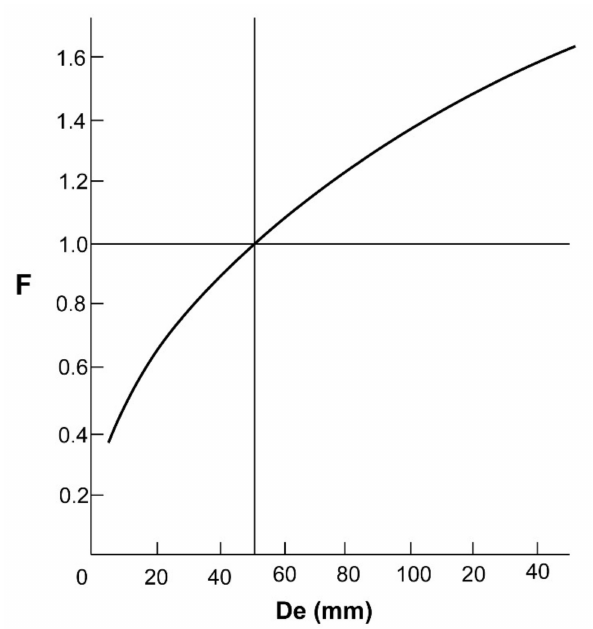
Figure A1. Graphical method to derive k correction factor.